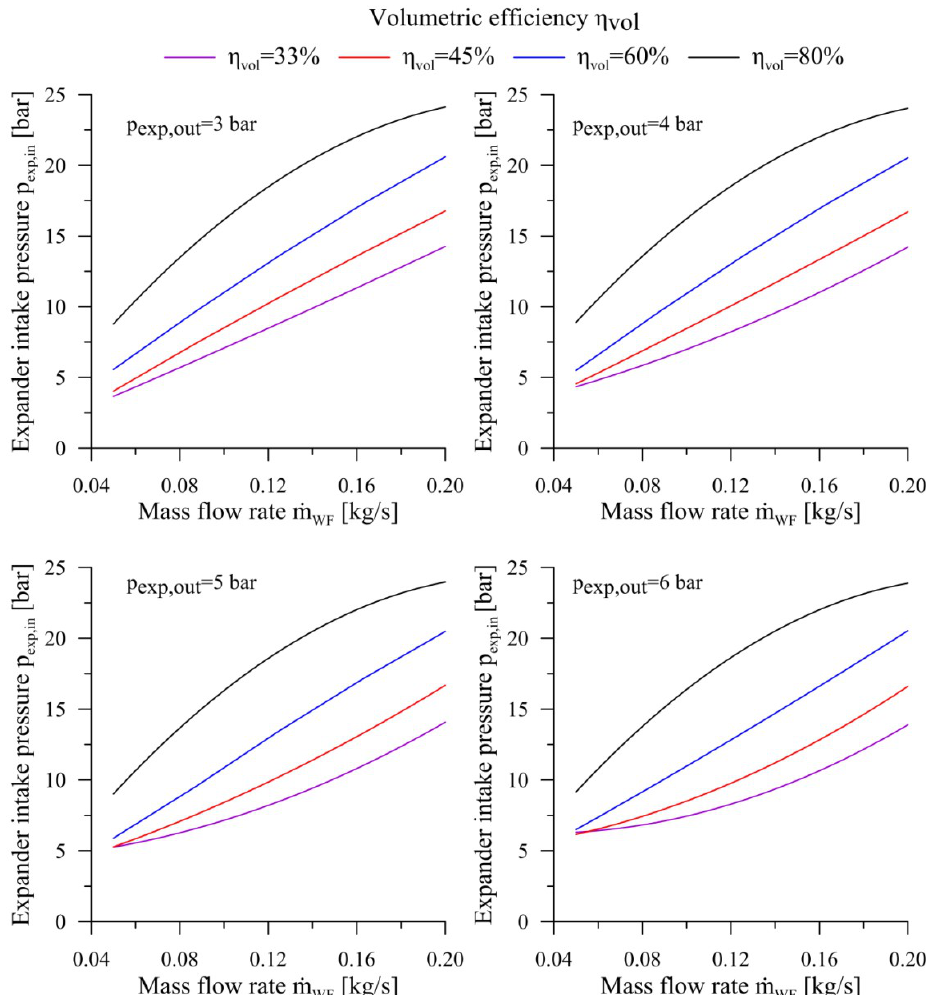
Figure 6. Diagnostic map of the expander operating condition.